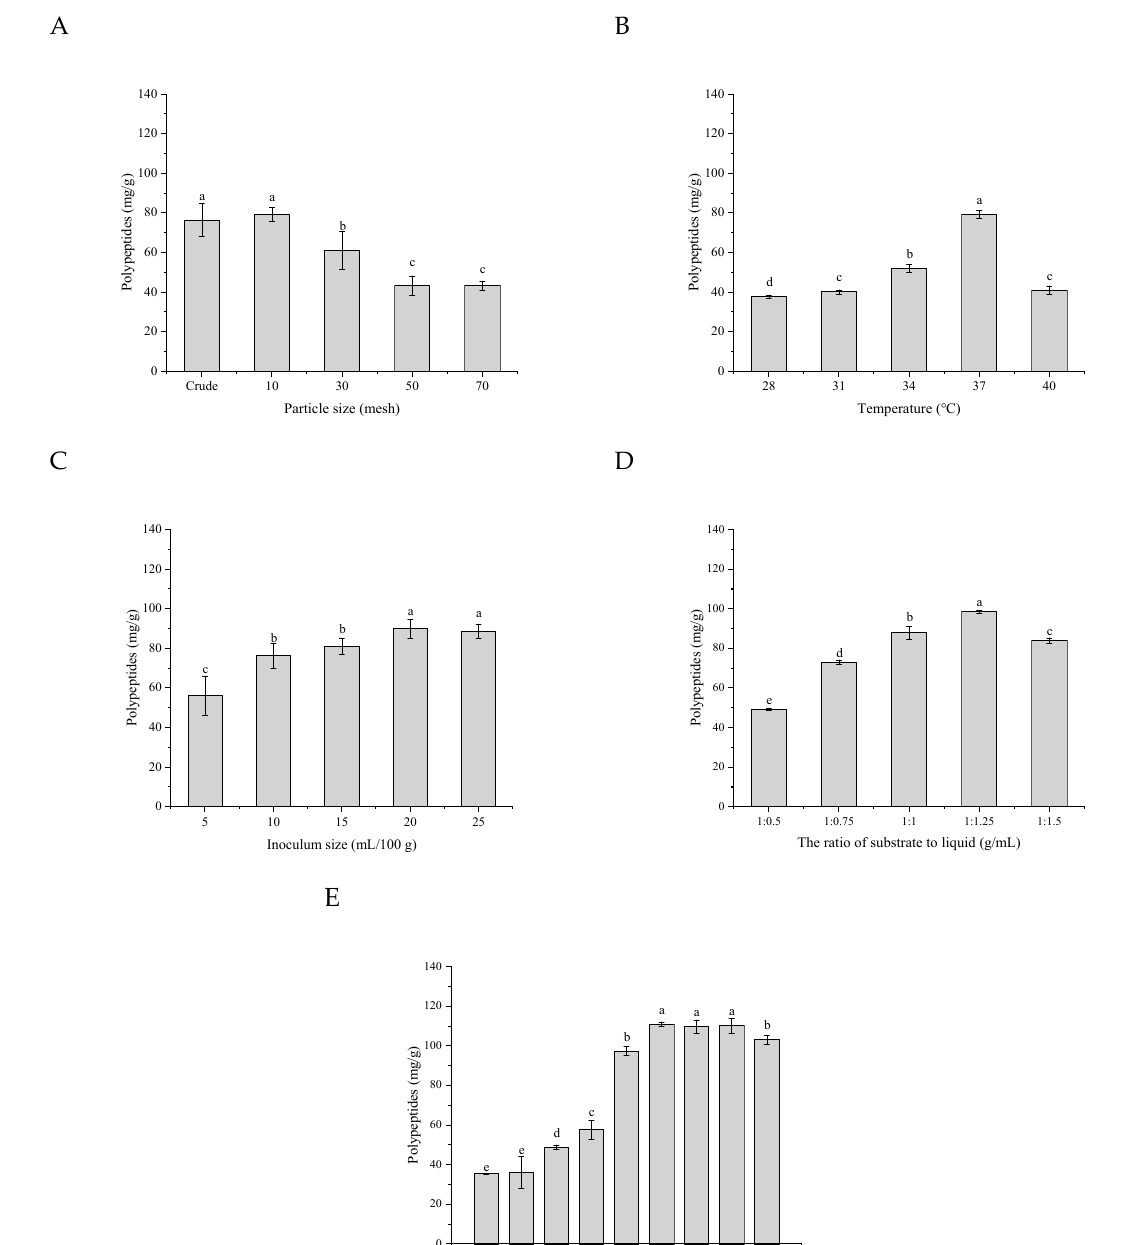
Figure 5. Effects of particle size of the matrix ( A ), fermentation temperature ( B ), inoculum size ( C ), the ratio of substrate to liquid ( D ), and fermentation time ( E ) on polypeptides after SSF by B. velezensis . Bars with different letters differ significantly ( p <